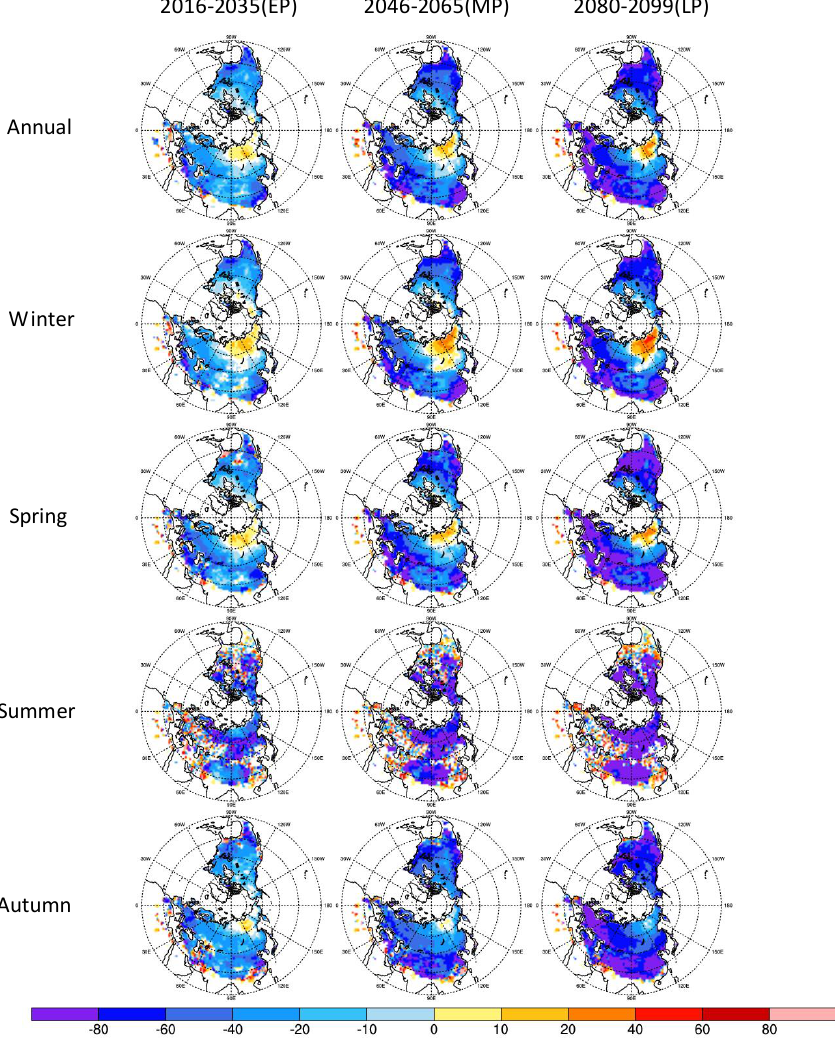
Figure 3. Projected relative change in mean annual and seasonal SWE (% relative to 1986–2005 reference period) by the CMIP5 ensemble for RCP8.5. The shade area indicates the change exceeds 95% significant